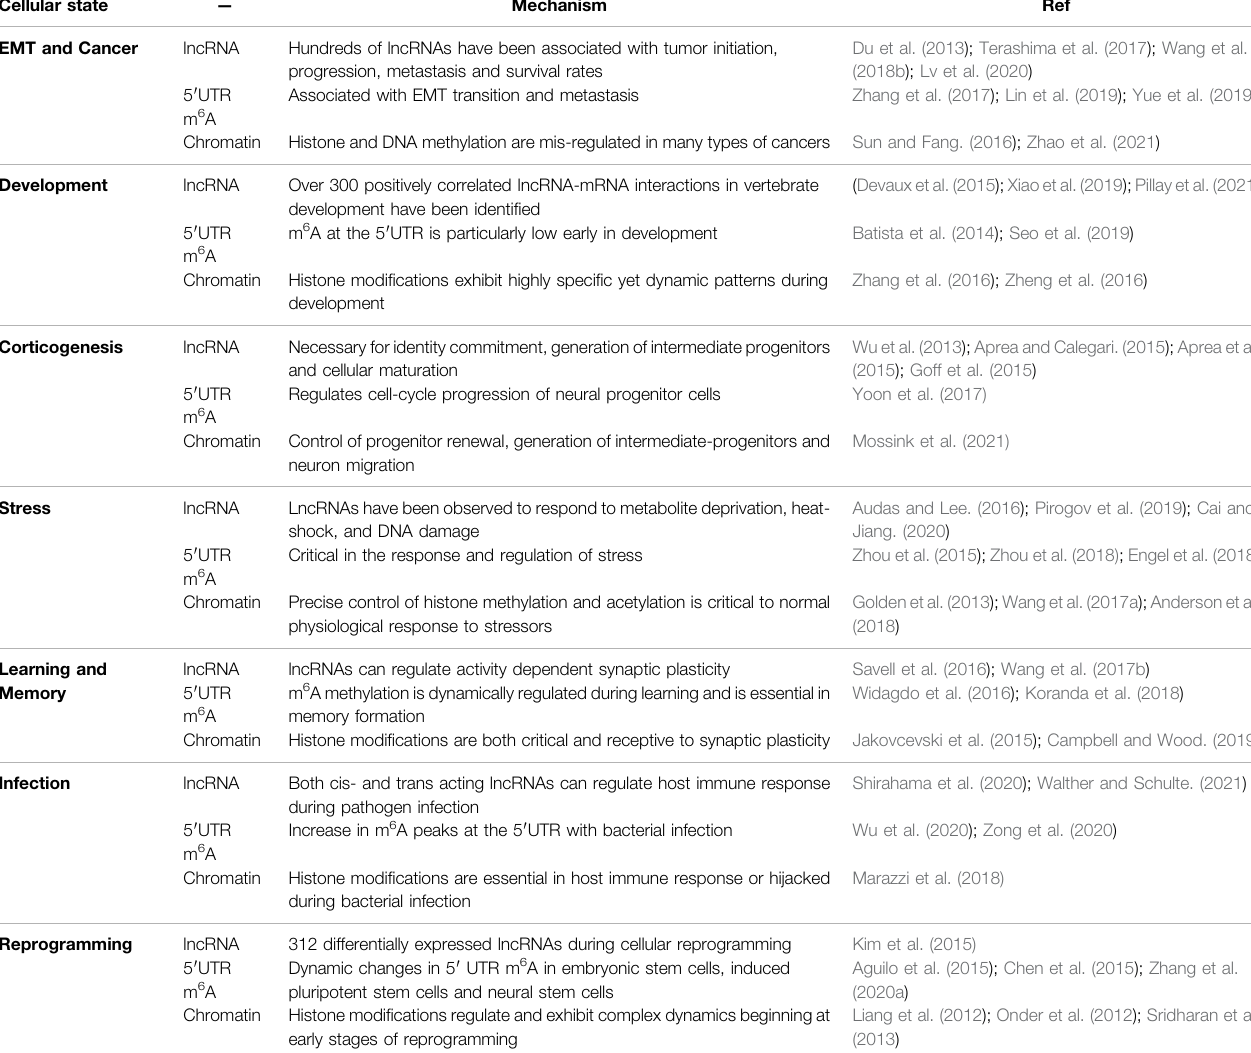
TABLE 1 | Correlation of regulatory dynamics in select biological and pathological